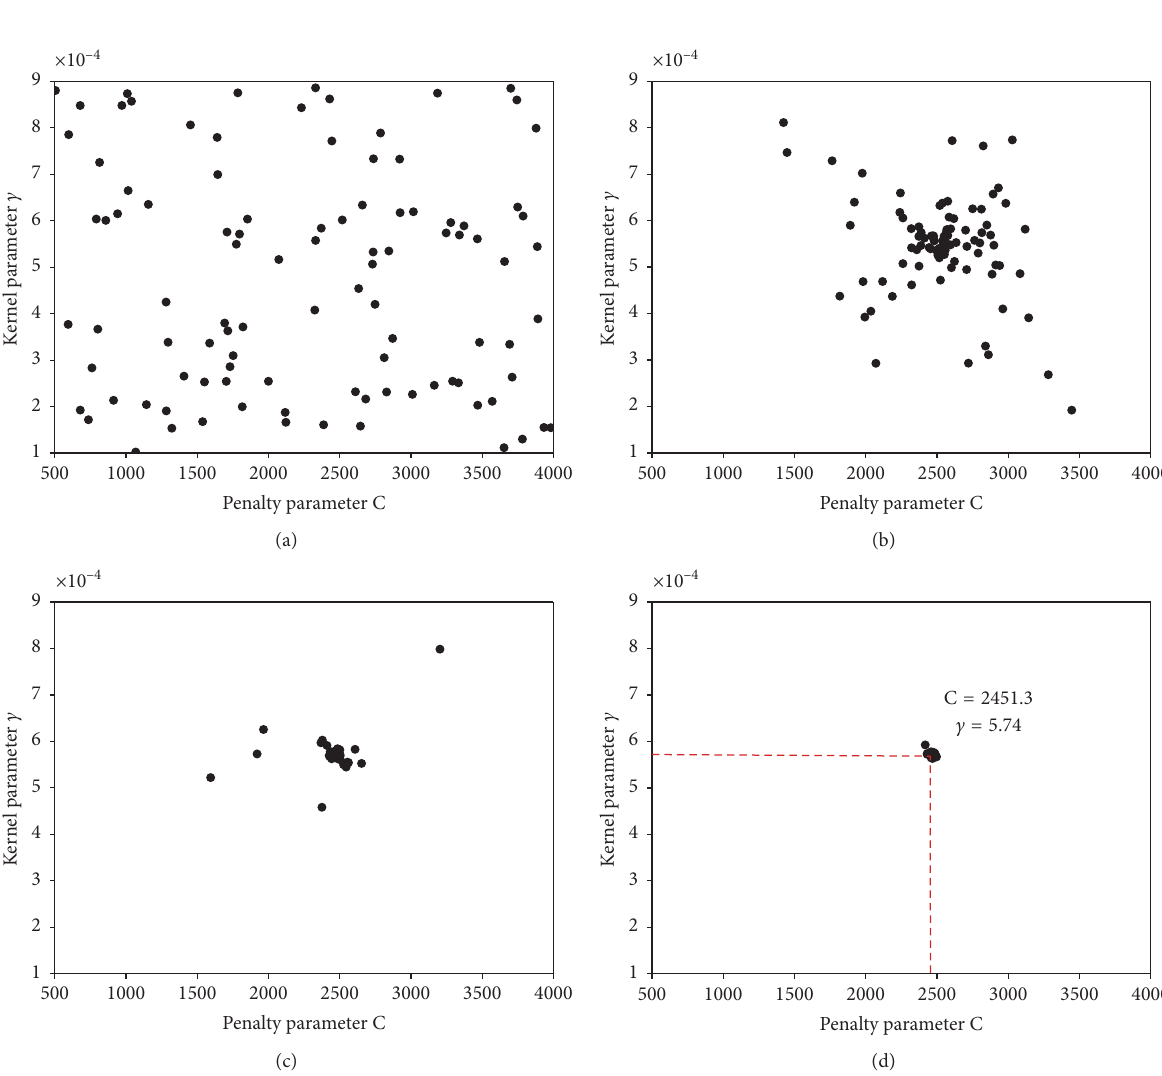
Figure 4: PSO convergence procedure: (a) random initialization; (b) 8 th iteration step; (c) 54 th iteration step; (d) 261 st iteration step, converge at C � 2451 . 3 and c � 5 .